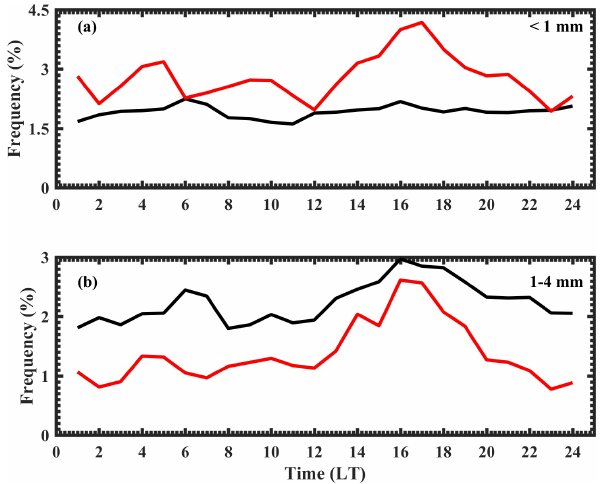
Figure 5. Diurnal variation in raindrop concentration during wet and dry spells for (a) smaller drops ( < 1mm) and (b) midsize drops (1–4mm). The concentration of raindrops within each hour is nor- malized with the total concentration of raindrops in the respective spells (wet or dry). The black line represents wet spells, and the red line represents dry spells.